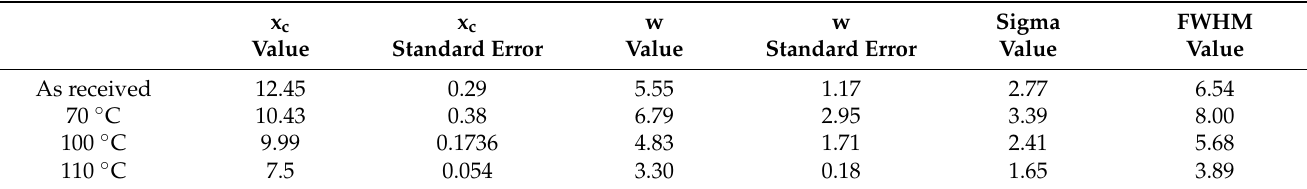
Table 3. The results of the Gaussian